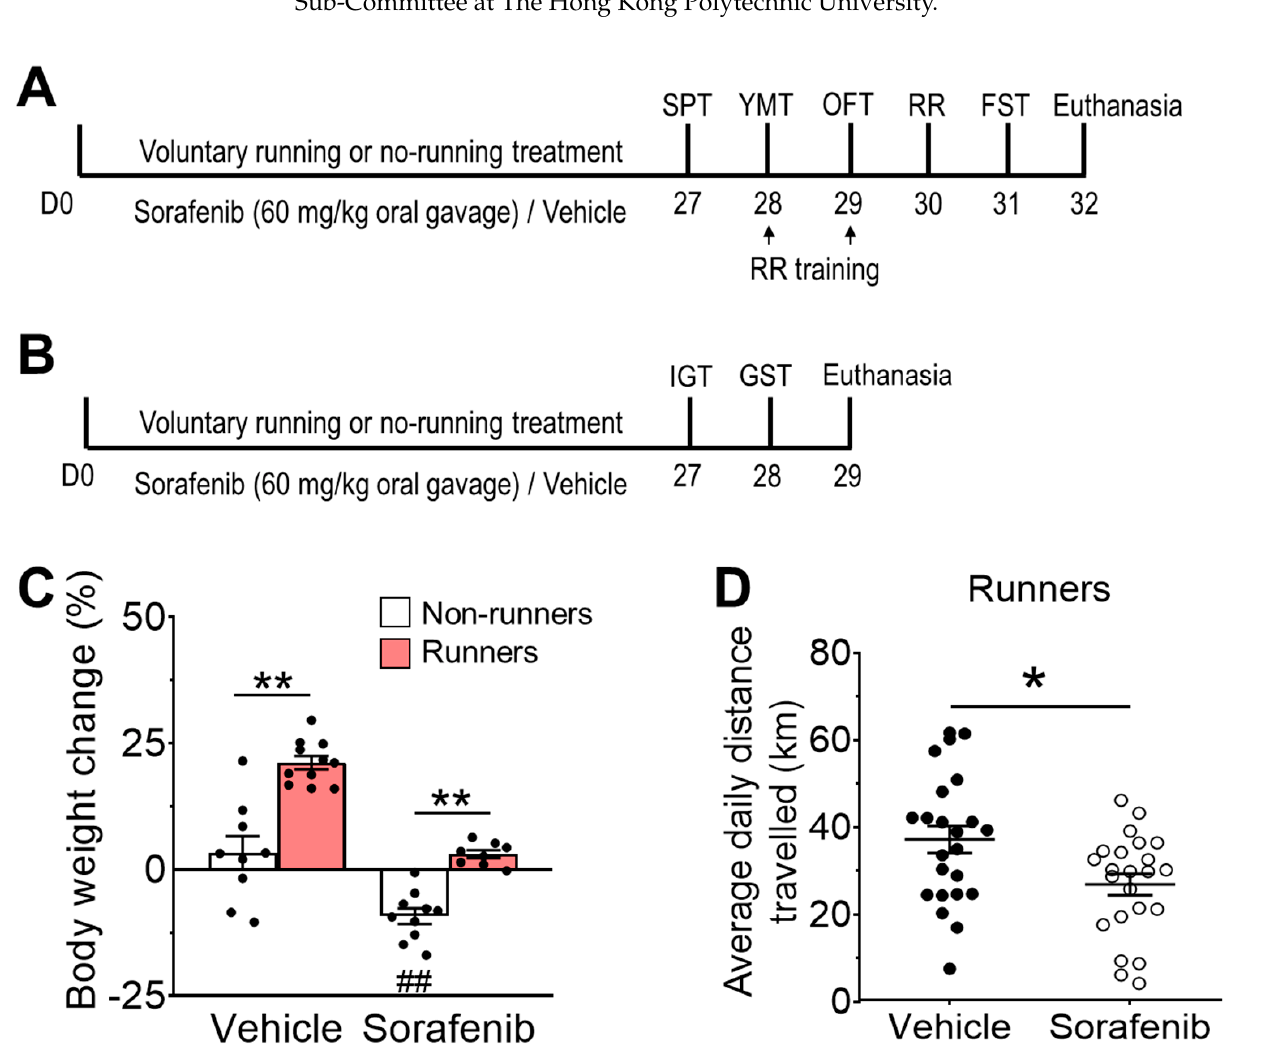
Figure 1. Voluntary running exercise attenuated sorafenib-induced weight loss. ( A ) Mice were housed with (runners) or without (non-runners) running wheels and were treated with sorafenib (60 mg/kg, oral gavage) or vehicle for 28 days continuously. They were then assessed by sucrose preference test (SPT), Y-maze test (YMT), open field test (OFT), rotarod test (RR), and forced swim test (FST). Fixed tissues were collected for histological analyses at the experimental endpoint. ( B ) In the second cohort, mice were submitted to muscle strength tests, including the inverted grip test (IGT) and grip strength test (GST) after the same treatment. Fresh skeletal muscles were collected at the experimental endpoint. ( C ) Sorafenib administration significantly reduced body weight. Con- comitant voluntary exercise promoted body weight gain in vehicle-treated runners and restored body weight loss in sorafenib-treated runners (Tukey’s post-hoc test: ** p < 0.005 vs. Vehicle + Non- runners & Vehicle + Runners; ## p < 0.005 vs. Vehicle + Non-runners). Results were expressed as